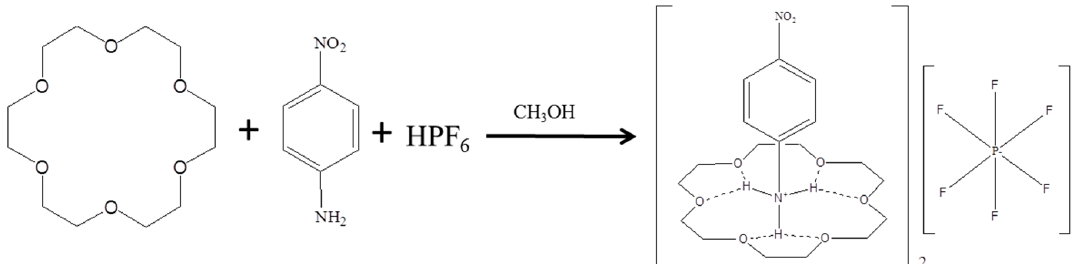
Scheme 1. Synthesis of compound 1 .